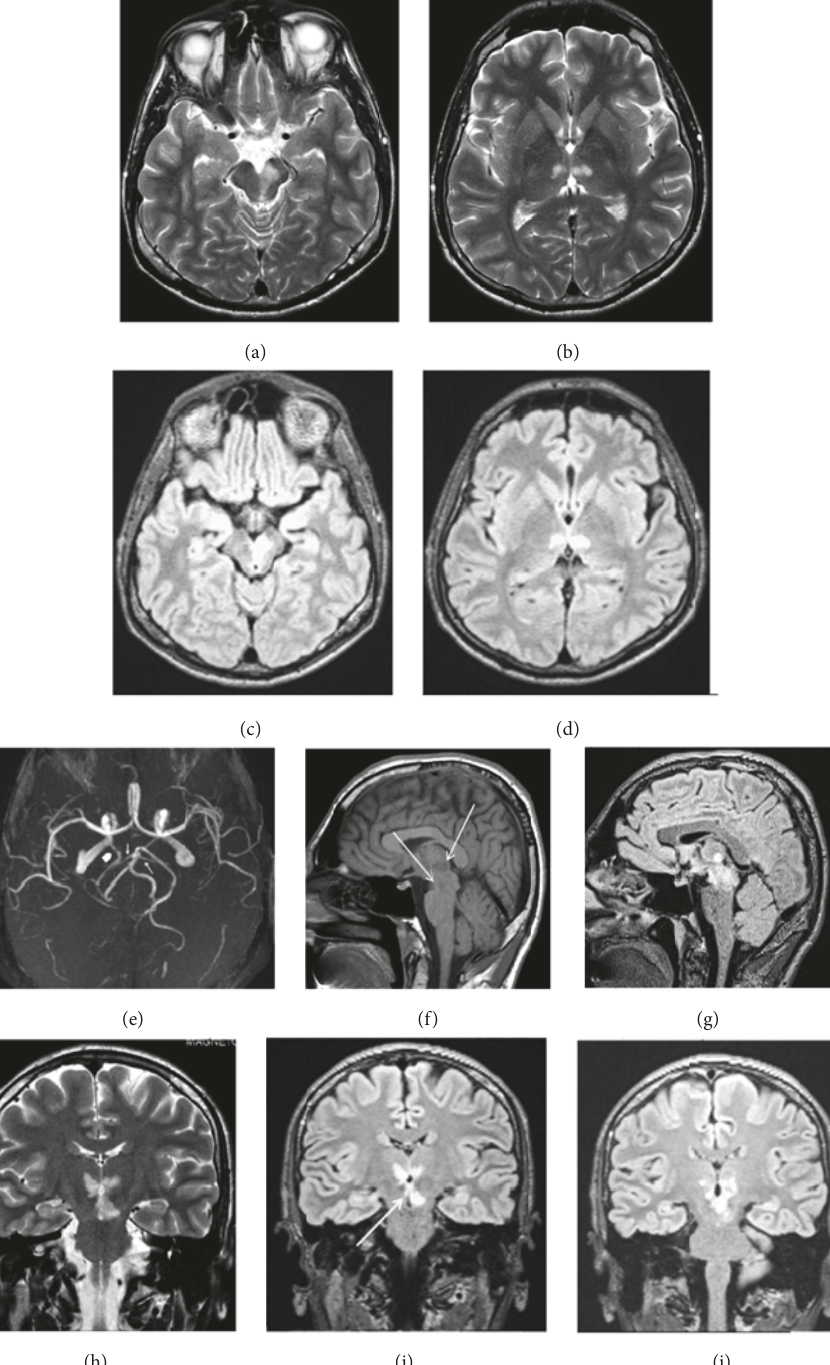
Figure 1: (a) Axial sections of T2-weighted images obtained 20 hours after the onset of symptoms showed areas of increased signal intensity in the left mesencephalon and (b) paramedian thalamic nuclei. (c, d) Axial brain FLAIR images. Hyperintense signals in the rostral midbrain and the paramedian thalamic suggest acute Percheron artery infarction. (c) “V-shaped” hyperintense signal along the pial surface of interpeduncular fossa in midbrain. The mesencephalon lesion extends to the periaqueductal gray matter. (e) MR angiography shows a right-sided FPCA (thick white arrow), arising directly from the ipsilateral internal carotid artery. Patency of the basilar artery and tip, left PCA, and posterior communicating artery; the thin arrows indicate the superior cerebellar arteries, with normal appearance. (f) Sagittal section, T1-weighted: showed ill-defined areas of hypodensity in the thalamopeduncular junction (white arrows). (g) Sagittal section, FLAIR: hyperintense images with the same topography. Coronal sections on T2 (h) and FLAIR images (i, j). Relatively symmetric hyperintense signals in the paramedian inferior thalami, extending (asymmetrically) into the medial and rostral mesencephalon (territory of the artery of Percheron).(i) Coronal section, FLAIR: “lambda-shaped” ( Λ ) hyperintense signal, adjacentto the pial layer of the interpeduncularfossa, next to the infarction zones in the thalamic–mesencephalon junction, equivalent version of the “V-shape” observed in axial sections (c). (FLAIR, fluid-attenuation inversion recovery images; FPCA, fetal posterior cerebral